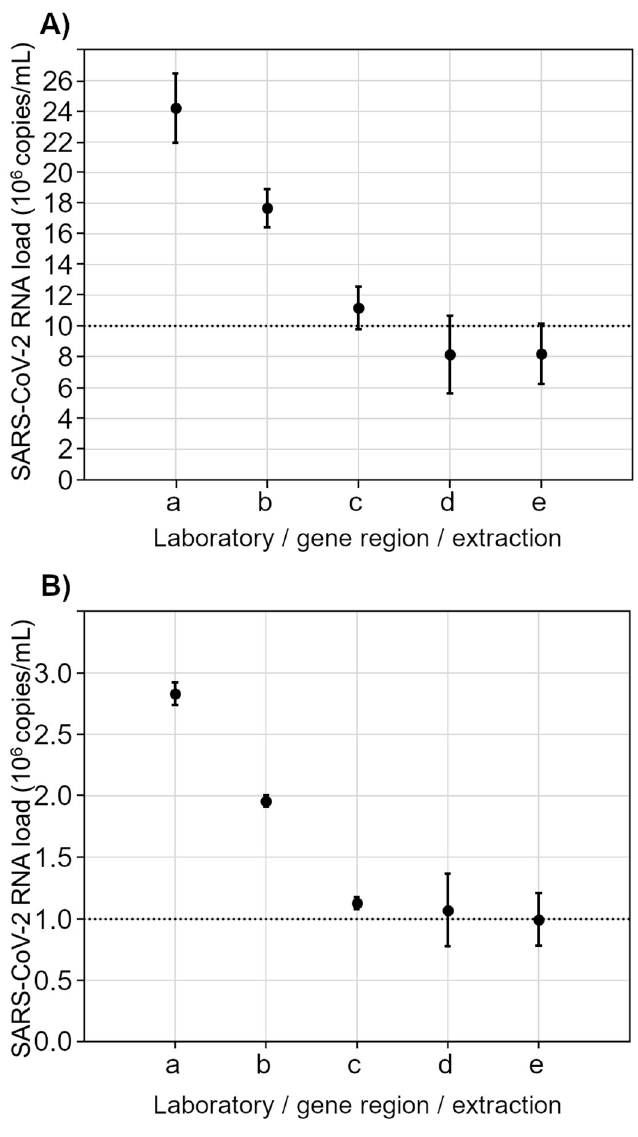
Fig 1. RT-PCR measurement results with 95% confidence intervals on the basis of quantification with synthetic RNA by laboratory 1 and laboratory 3 for RM 1 (A) and RM 2 (B) with details on extraction, amplification and target gene. a = laboratory 1/extraction: Qiagen QIAamp Viral RNA Mini Kit/amplification: in-house/gene region: E gene b = laboratory 1/extraction: Roche MagNA Pure 96 Viral NA Small Volume Kit/amplification: in-house/gene region: E gene c = laboratory 3/extraction: Qiagen QIAamp Viral RNA Mini Kit/amplification: in-house/gene region: E gene d = laboratory 1/extraction: Qiagen QIAamp Viral RNA Mini Kit/amplification: in-house/gene region: RdRP gene e = laboratory 1/extraction: Roche MagNA Pure 96 Viral NA Small Volume Kit/amplification: in-house/gene region: RdRP gene The dotted line in (A) represents the expected SARS-CoV-2 RNA loads of 10 7 copies/ml for RM 1. The dotted line in (B) represents the expected SARS-CoV-2 RNA loads of 10 6 copies/ml for RM